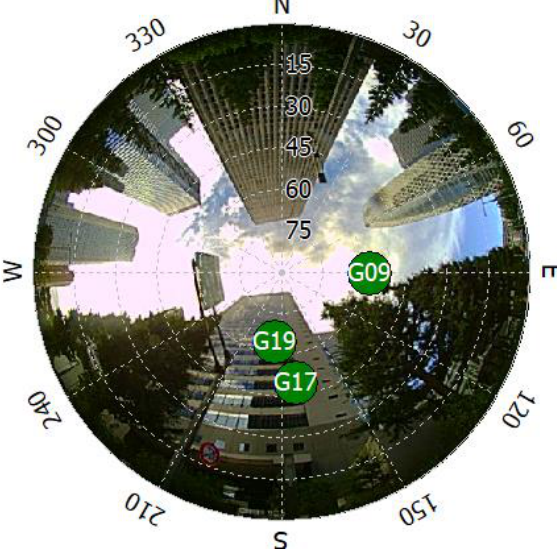
Figure 10. GPS satellite projection on a fish-eye